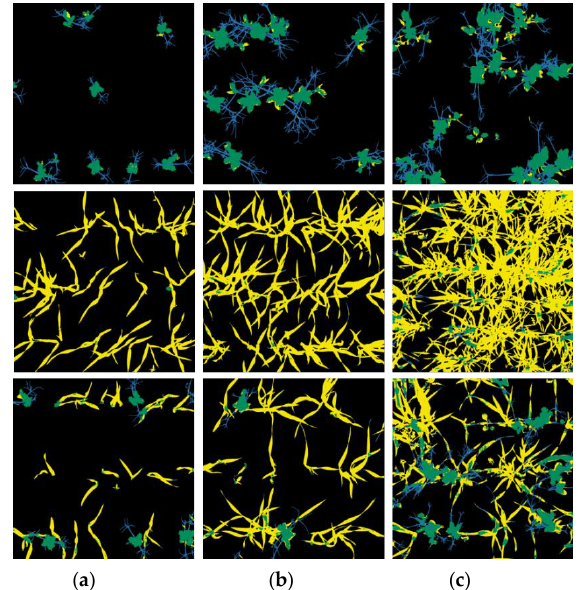
Figure 5. Examples for images from the three datasets: ( a ) low, ( b ) intermediate, and ( c ) high cover analyzed by the network trained on all datasets (LC + IC + HC). From top to bottom: pea, oat, and pea – oat intercrops (yellow: oat, green: pea, blue: pea tendrils).